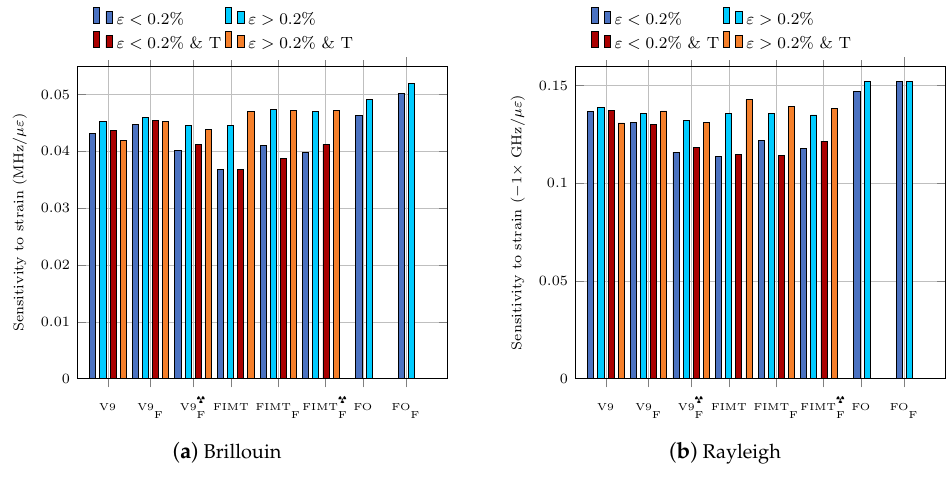
Figure 1. Sensitivity to strain of different